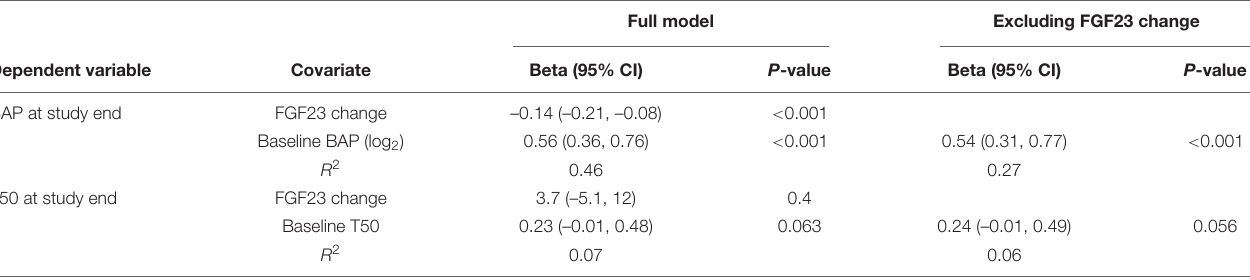
TABLE 3 | Linear regression models for BAP and serum calcification propensity score test (T50) at study